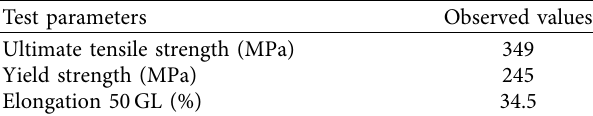
Table 2: Basic tensile properties of base metal.